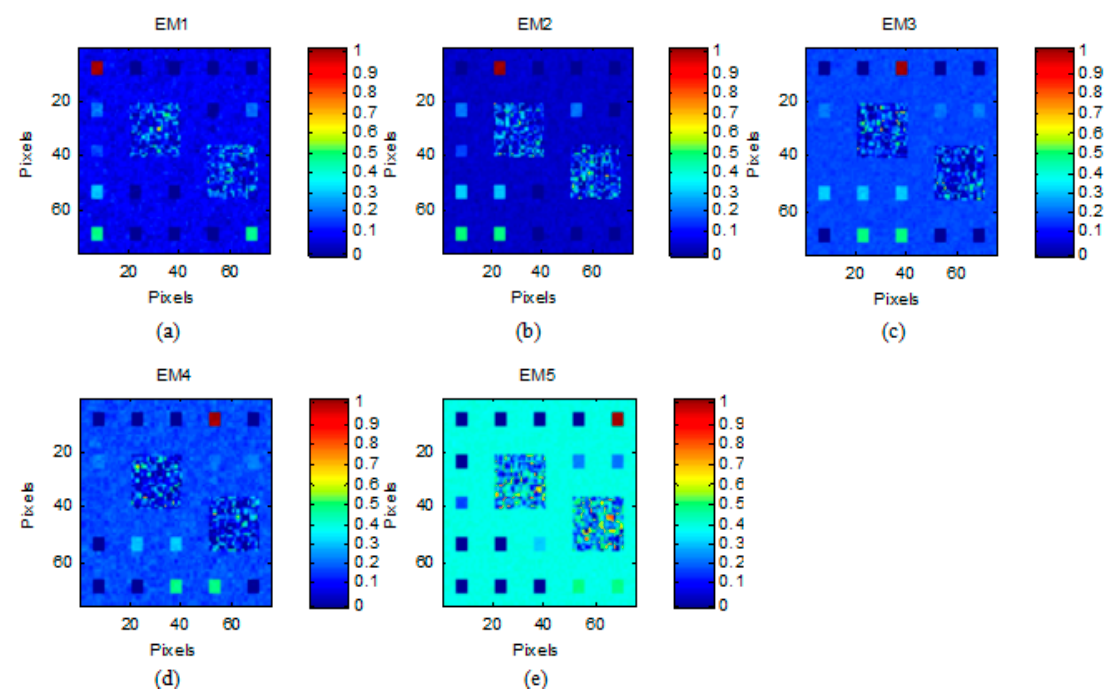
Figure 7. Abundance maps obtained by the proposed unmixing method in DC3 and the SNR is 40 dB: ( a ) the true abundance of endmember 1; ( b ) the true abundance of endmember 2; ( c ) the true abundance of endmember 3; ( d ) the true abundance of endmember 4; and ( e ) the true abundance of endmember 5.